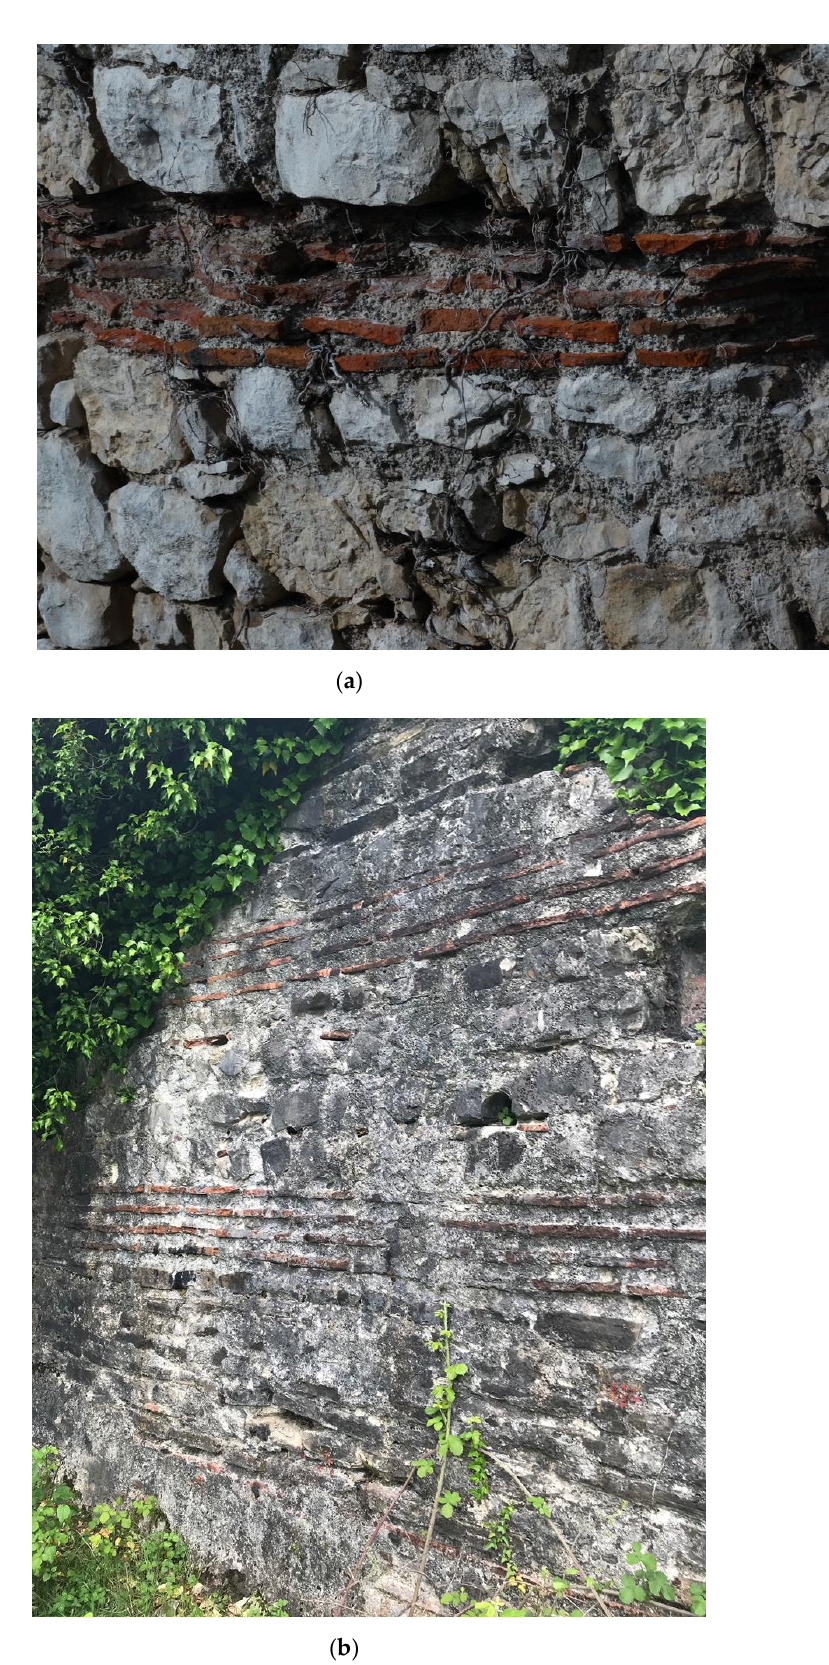
Figure 2. Dilapidated brickwork on lime mortar in the ancient city of Ephesus (Turkey, II century AD): ( a ) Partly preserved brick and stone facade of the building; ( b ) Fragment of the destroyed brick arch.